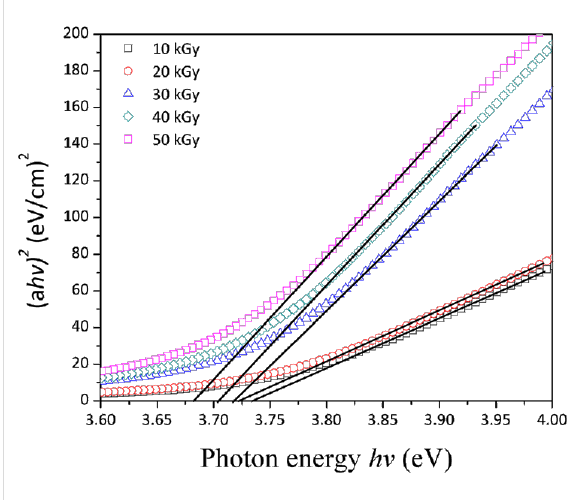
Figure 6: Optical band gap energy of ZnS NPs after irradiation with doses of 10 to 50 kGy.